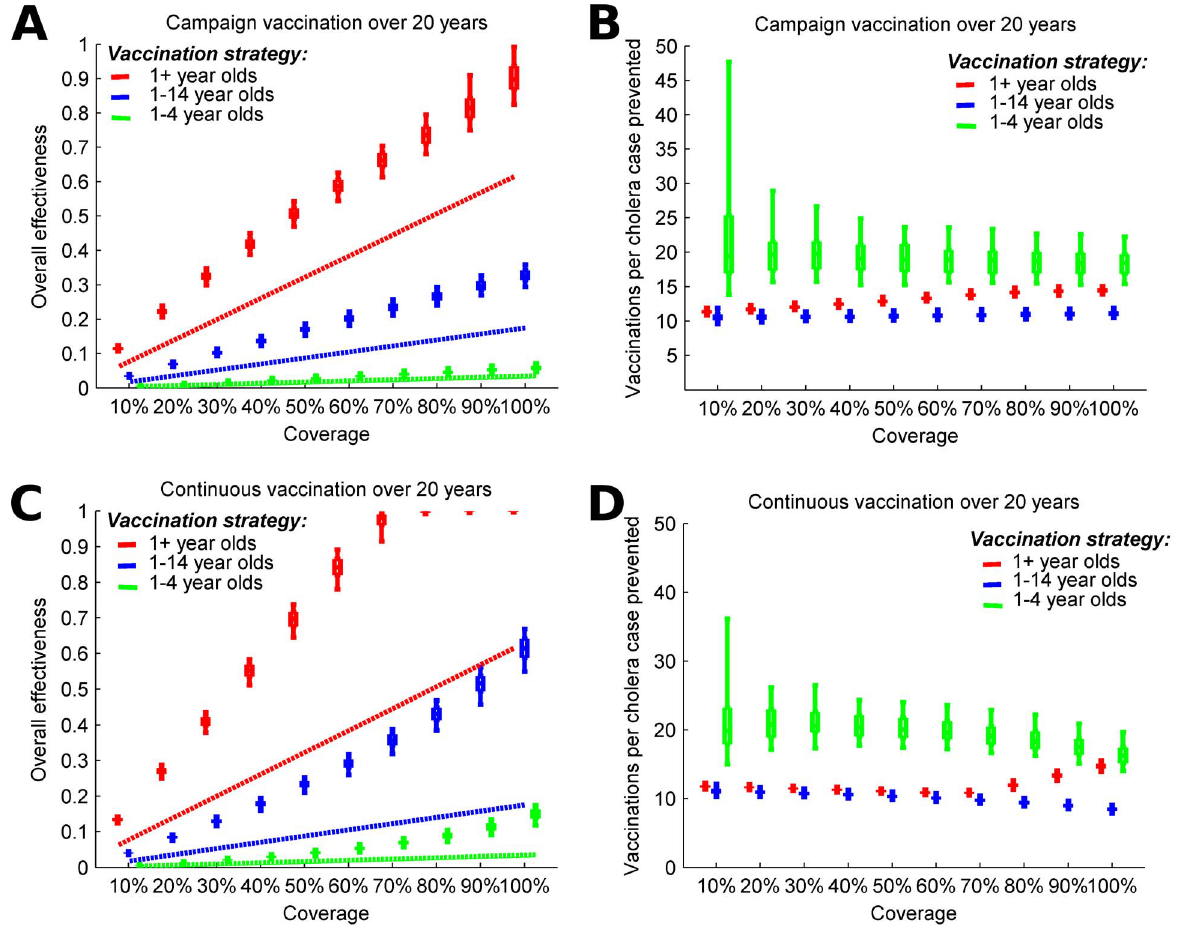
Figure 4. Modeling 5-year campaign and continuous vaccination strategies for vaccine with different coverage levels and targeting different age groups. A) Overall effectiveness and B) vaccinations per case prevented by mass vaccination campaigns that occur every 5 years. C) Overall effectiveness and D) vaccinations per case prevented by continuous vaccination. We assume that the vaccine protects for an average of 5 years and is less effective among children from ages 1 to 4 years (40% efficacy) than among older individuals (65% efficacy). Overall effectiveness is the prevented fraction of cholera cases over 20 years. The boxes represent the interquartile range and the whiskers cover 90% of the results from 100 simulations per scenario with parameters of seasonal environmental exposure sampled from ranges in Table S3. Dashed lines show the effectiveness if only direct effects of the vaccine are considered.